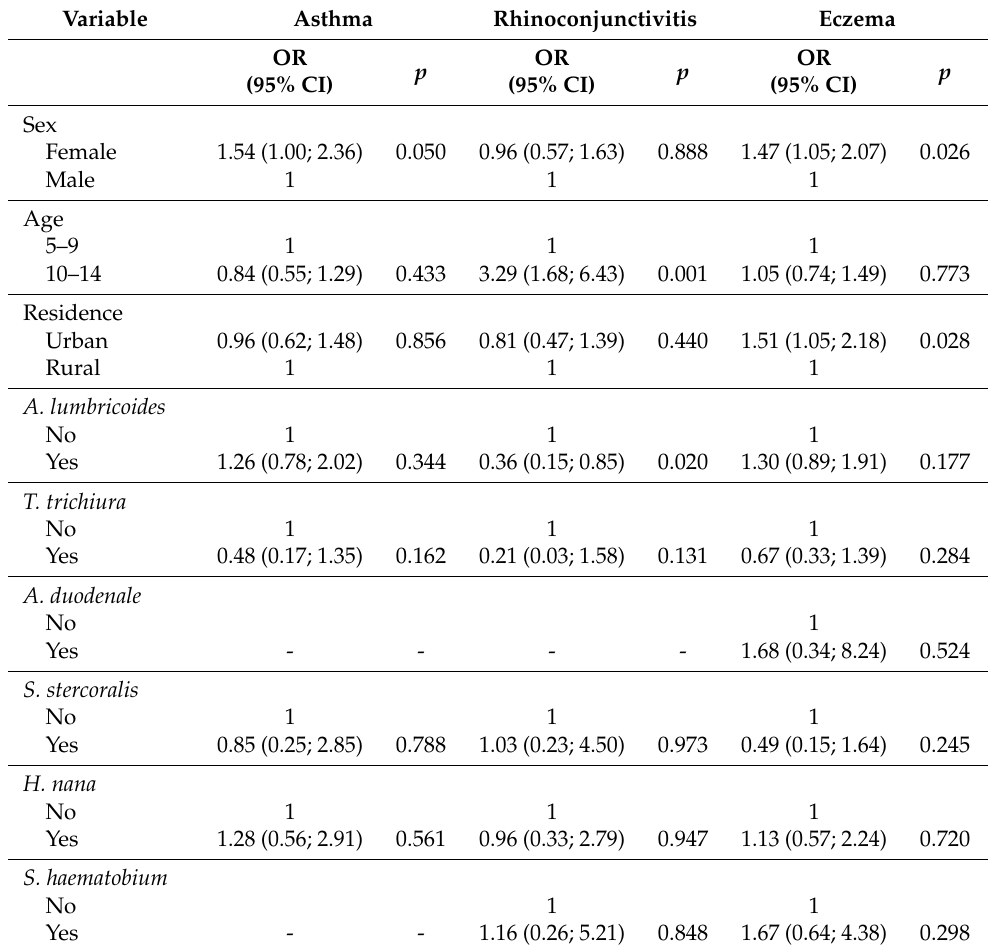
Table 3. Multivariate analyses for allergic